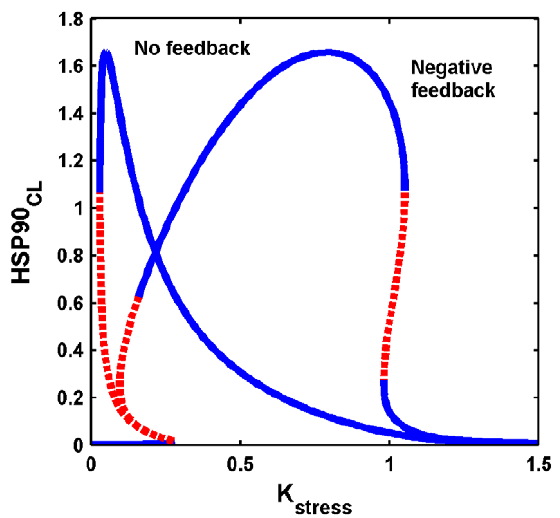
Figure 10. Bifurcation diagram in the absence of the negative feedback loop. One-parameter bifurcation diagram is constructed in the absence of negative feedback loop by silencing the kinetic constants k 1 and and k { 1 to zero. Only the S-shaped part of the mushroom is seen, and the Z-shaped part is absent. This indicates that to generate Z-shaped bistable part, a strong negative feedback loop is important, and this strong feedback loop may be responsible for the occurrence of depression and post-traumatic stress disorder (PTSD) (see also Fig. 7).